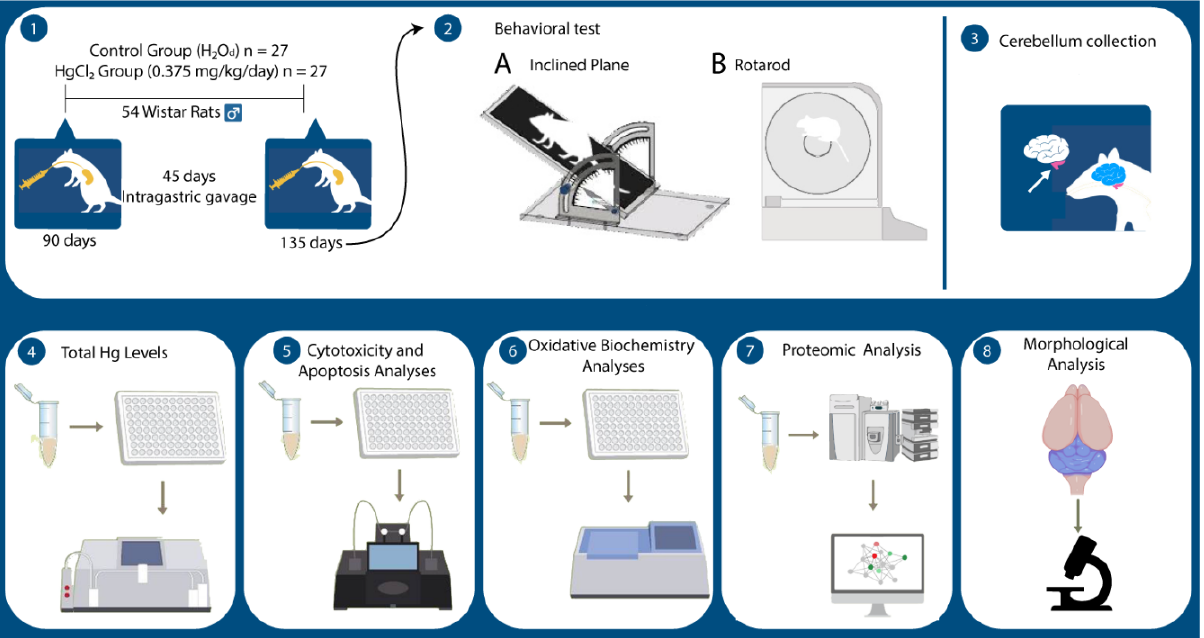
Figure 8. Schematic figure of all methodological steps. In ( 1 ), the experimental protocol of HgCl 2 long-term exposure in adult Wistar rats, followed by motor functions assessment ( 2 ) by inclined plane ( A ) and rotarod ( B ) tests and then, cerebellum collection ( 3 ); in ( 4 ), quantification of total mercury (Hg) levels by atomic absorption spectrometry; in ( 5 ), oxidative biochemistry analyses by the determination of lipid peroxidation (LPO) levels and antioxidant activity against peroxyl radicals (ACAPs); in ( 6 ), proteomic analysis by mass spectrometry with bioinformatics analysis though Cytoscape software. In ( 7 ), evaluation of cell death nature by cytotoxicity and apoptosis assays and in ( 8 ), Purkinje cell counting by bright field microscopy.